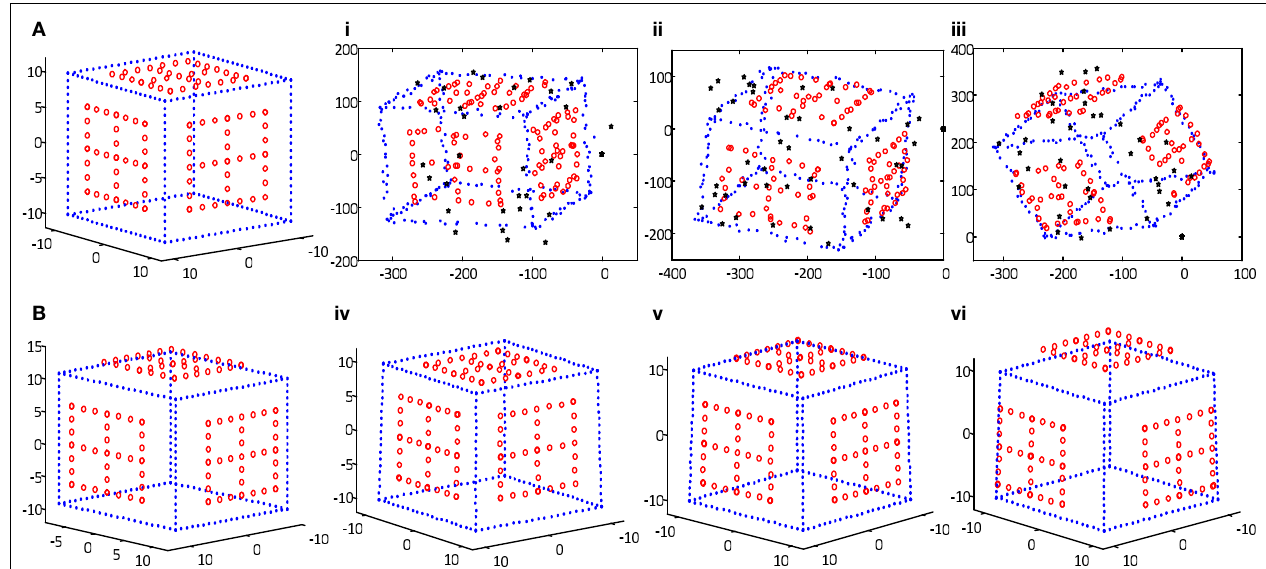
FIGURE 3 | (A,B) Two simulated space cubes with three sets of moving points; (i–iii) three synthetic images with noise and outliers (black stars); (iv–vi) the reconstructed 3D structures corresponding to the three images.